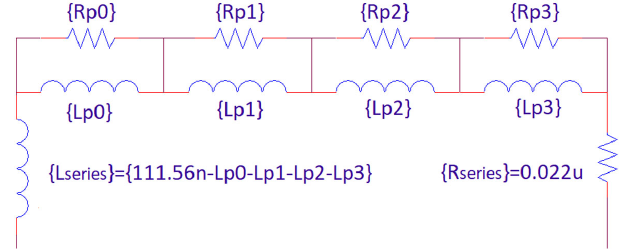
FIG. 16. Equivalent circuit of the frequency dependent induct- ance per cell of the kicker magnet.